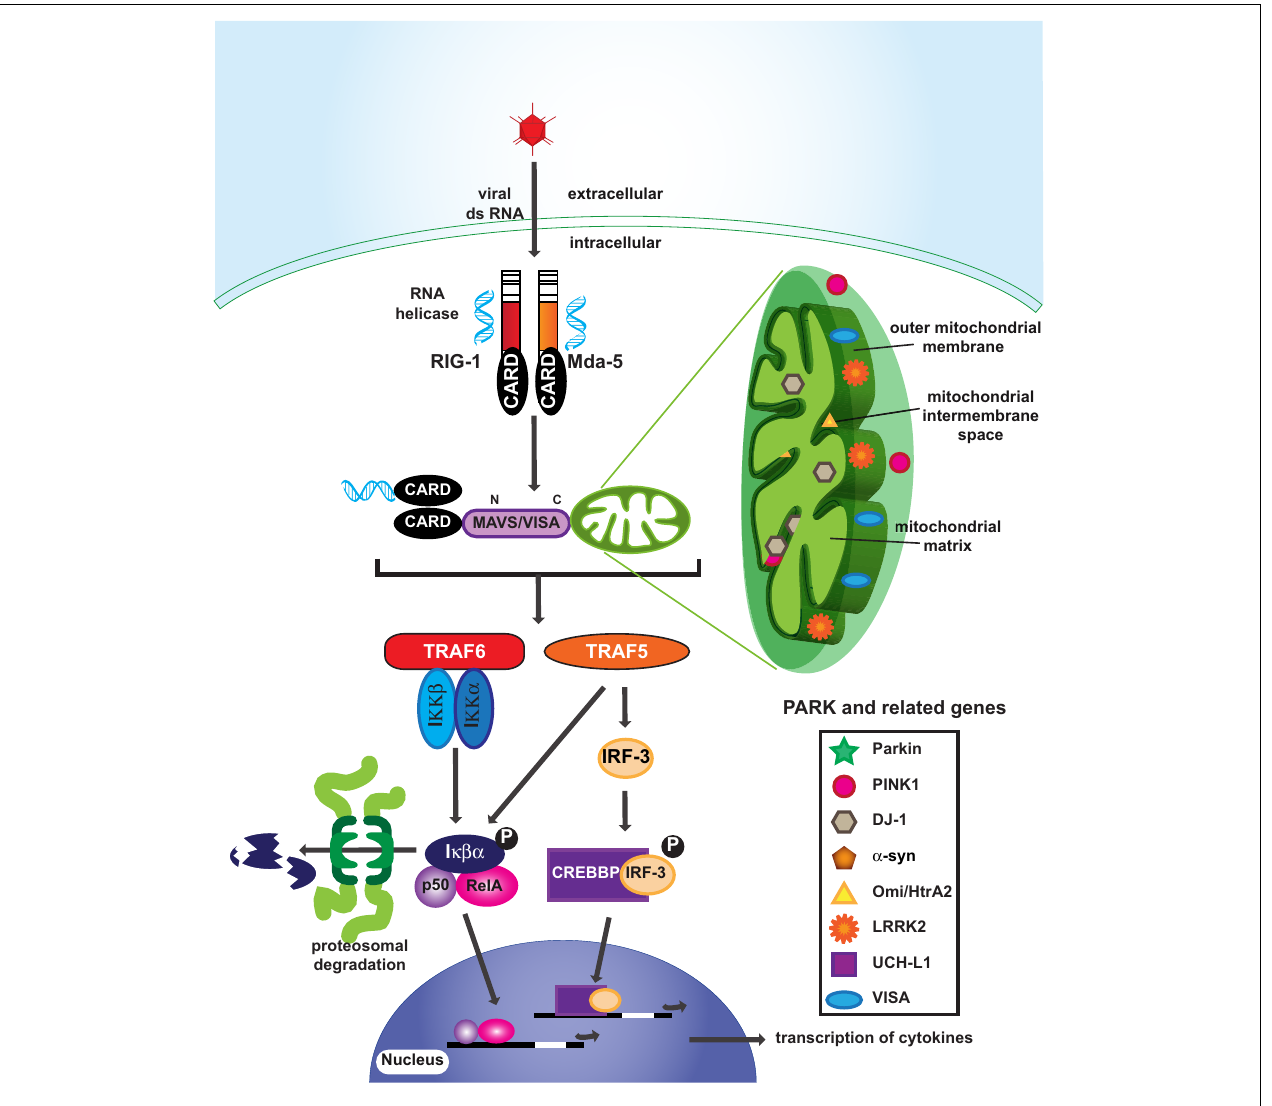
membrane of mitochondria are involved in viral infection signaling by activatingTRAF6 andTRAF5. Phosphorylation of I κβα and IRF-3 leads to nuclear translocation of transcription factors and the production of cytokines.